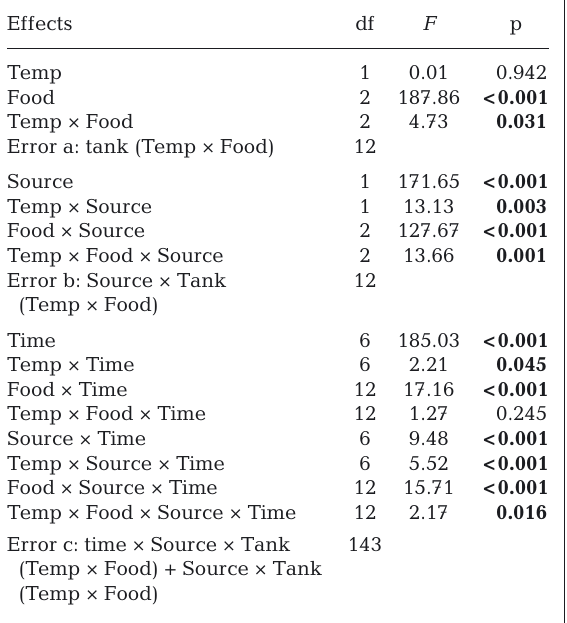
Table 3. Summary of generalized linear mixed-effects model to assess the effects of temperature (Temp, 16.5 vs. 22°C), food level (starved, low and high), source (tank inlet vs. out- let) and time on levels of OsHV-1 DNA concentration in sea water. Data were log( x + 1) transformed. Significant p- values (p < 0.05) are in